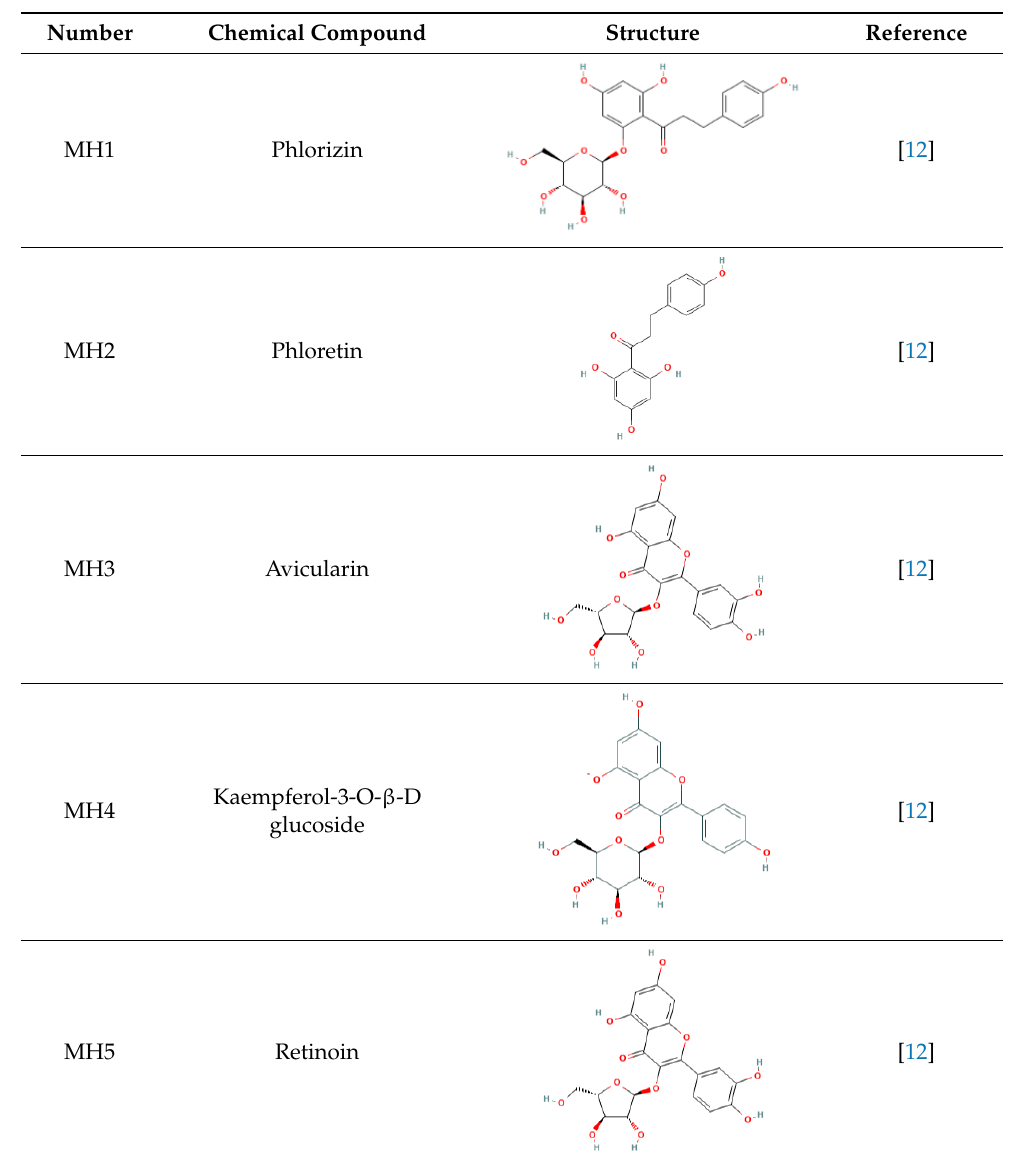
Table 1. The bioactive substances in MH.